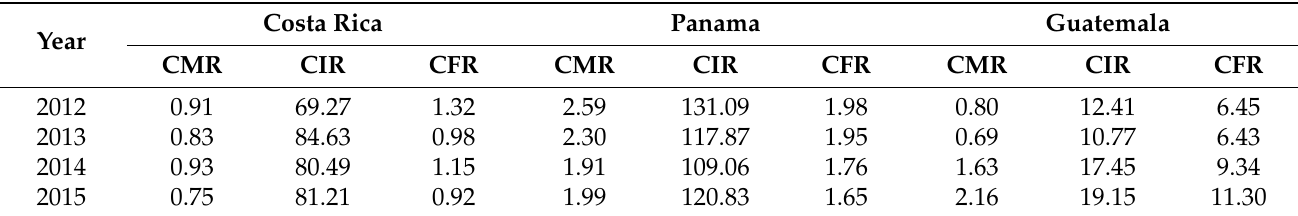
Table 3. Crude MVC-related mortality, injury, and fatality rates for 0 to 14-year-olds in Costa Rica, Guatemala, and Panama 2012–2015.